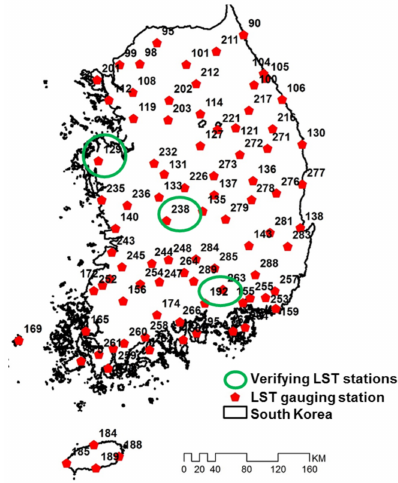
Figure 5. Map of observed land surface temperature (LST) stations: ellipses (in green) denote the stations excluded from the conditional merging (CM) process and used for verification. The number above each pentagon (in red) is the LST station number.